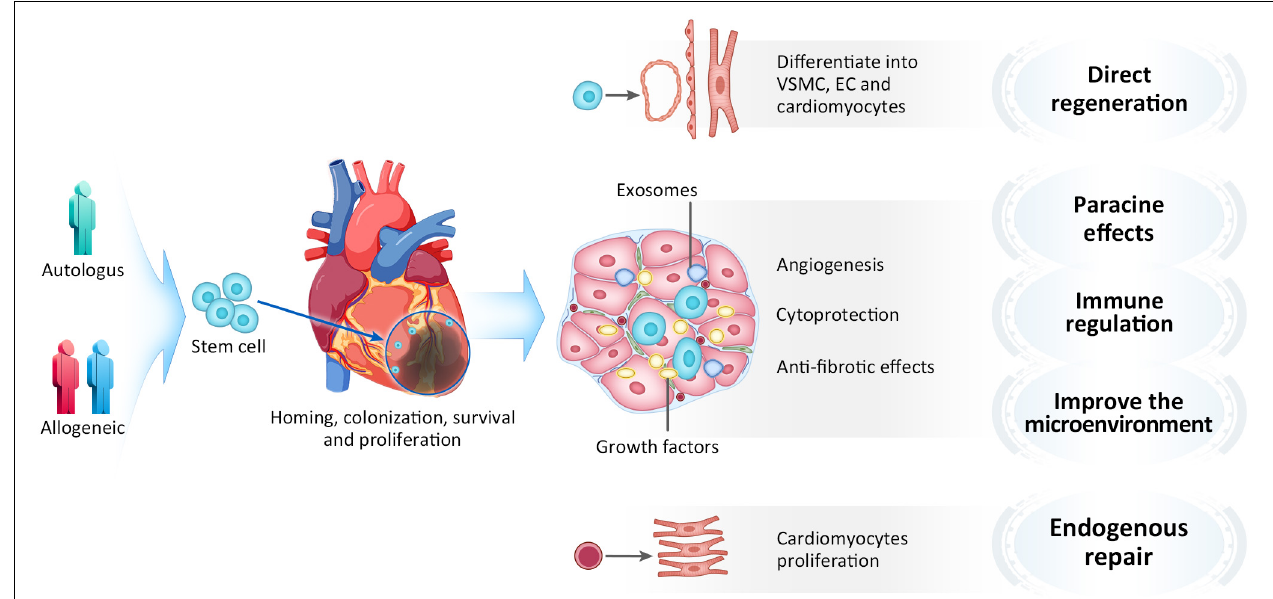
FIGURE 4 | Mechanism of stem cell therapy. VSMC, Vascular smooth muscle cell; EC, Endothelial cell.